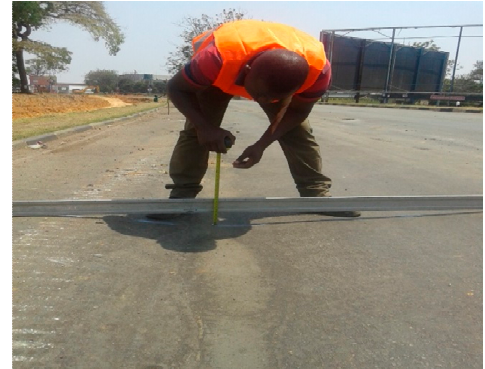
Figure 5. Trench measurements of Pit 2 (Kitwe-Ndola).